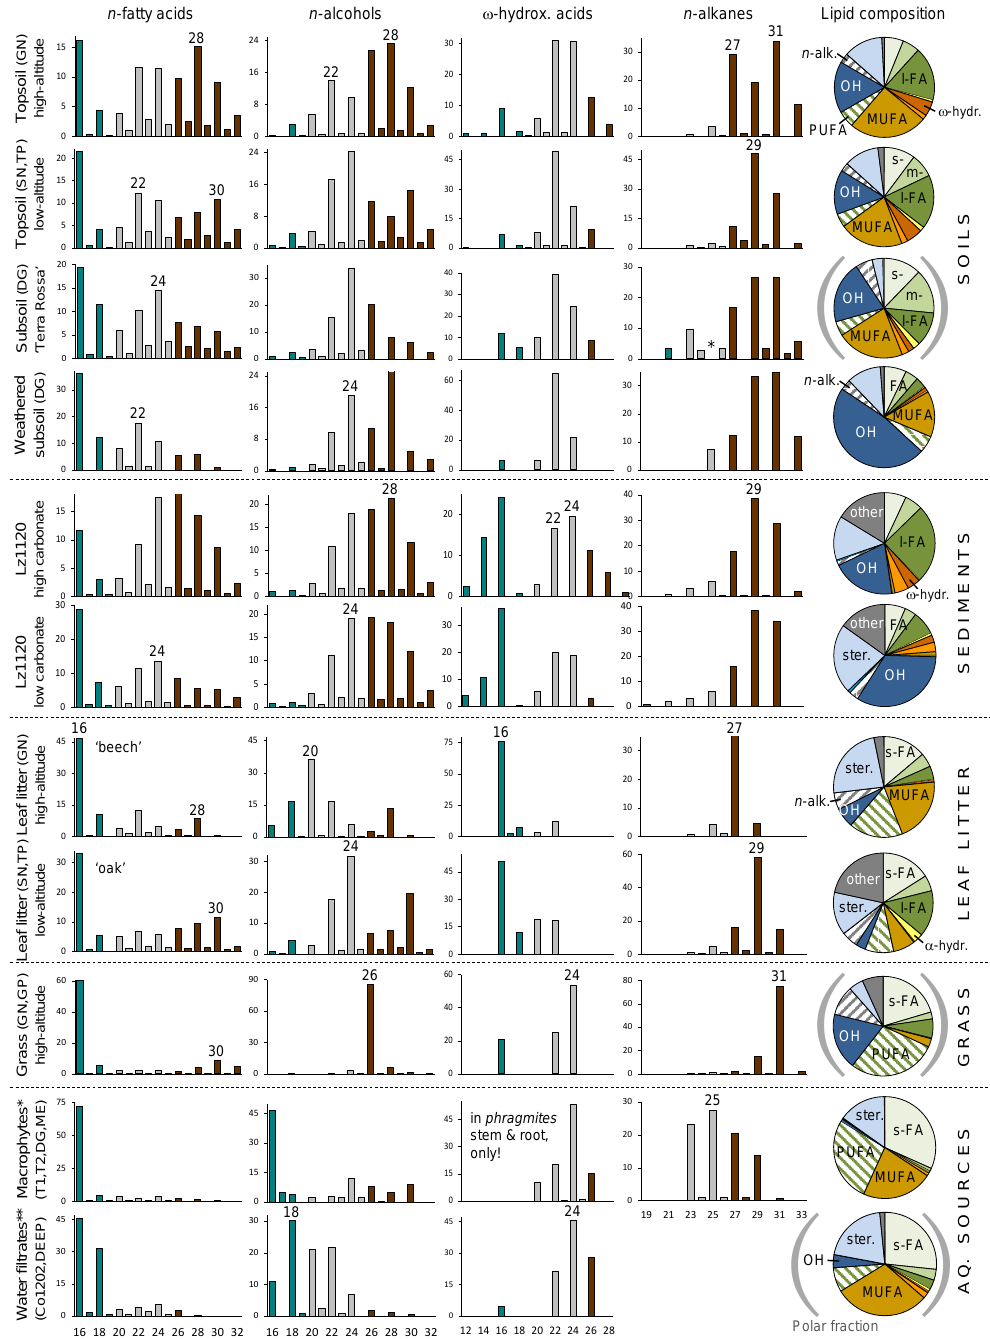
Figure 3. Chain-length distributions of n -alkyl compounds (bar diagrams) in high- and low-altitude topsoil, subsoil (un-weathered and weathered Terra Rossa), early Holocene sediments, in high- and low-altitude leaf litter, high-altitude grasses, macrophytes and water filtrates and the composition of GC-amendable lipids (pie diagrams). Chain-length distribution y axis values are percentages of the total amount of each compound class, i.e. % FA ,% OH etc.; s-,m-, l-FA is short-, mid- and long-chain FA, respectively; MUFA is mono-unsaturated FA; PUFA is poly-unsaturated FA; ster. is sterols; hydr. is hydroxy acids; br. FA is branched FA; asterisk (*): co-elution of n -C 25 with contaminant; lipid composition for un-weathered Terra Rossa is likely less accurate as response factors for main compounds were not determined. Note the distinct shift towards C 22 and C 24 in chain-length distributions of FAs and towards C 24 in chain-length distributions of OHs from high to low carbonate sediment samples. C 12 and C 14 ω -hydroxy acids in the sediments appear to derive from an in situ source. Macrophyte data derives from submerged species, except for the ω -hydroxy acids, which exclusively occur in (emergent) Phragmites sp. The accuracy of the lipid composition of the grasses is limited since response factors could not be determined for the main compound classes. Water filtrate data do not include non-polar compounds (e.g. n -alkanes) as these were separated from the polar TLE fractions prior to further sample